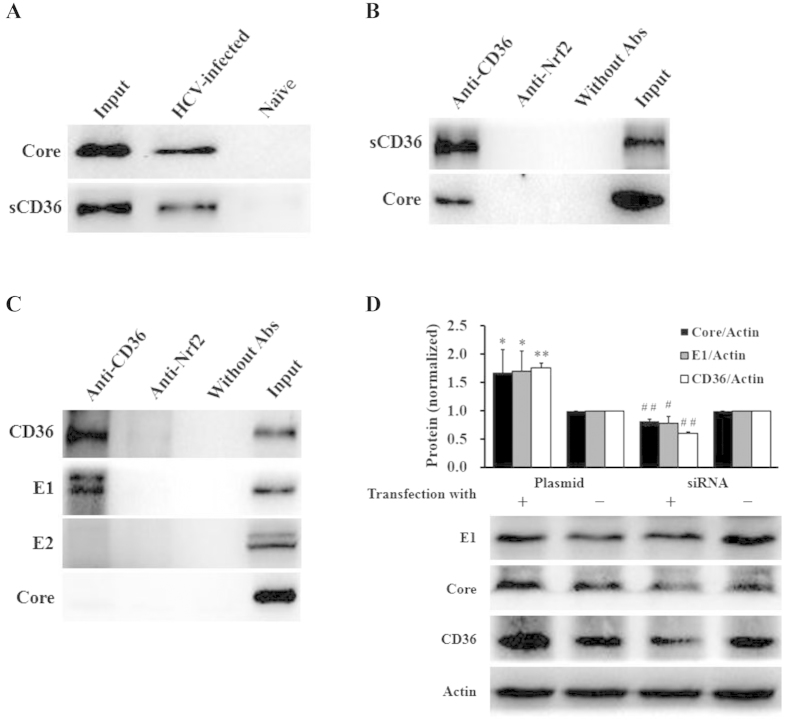
CD36 directly interacted with HCV E1 protein.(A) HCV particles bound sCD36 in culture supernatants. The culture supernatants of HCV-infected or naïve Huh7.5 cells were ultracentrifuged, and HCV viral components (Core) and sCD36 were simultaneously detected in the precipitates using western blot. (B) sCD36 bound onto HCV particles in culture supernatants (Co-IP assay). Co-IP with anti-CD36 mAb from the supernatants of HCV-infected Huh7.5 cells brought down HCV particles. (C) CD36 directly bound HCV E1 protein. Co-IP was performed with the lysates of HCV-infected Huh7.5 cells. Anti-Nrf2 antibody was used as an irrelevant negative control, and Without Abs as blank control in (B,C). (D) CD36 on cell membrane helped host to capture HCV particles (n = 3). After 48 hrs transfection with plasmid or siRNA for CD36, 293T/17 cells (resistant to HCV infection) were washed and incubated with HCV (300 IU/cell) for 3 hrs, followed by washing and then treating with lysis buffer. CD36 and HCV proteins in the lysates were analyzed with western blot. *P < 0.05, vs plasmid control (−); #P < 0.05 and ##P < 0.01, vs siRNA control (−). The protein bands presented showed the results of a representative experiment. Presented are mean ± standard deviation, and Student’s t-test was used.